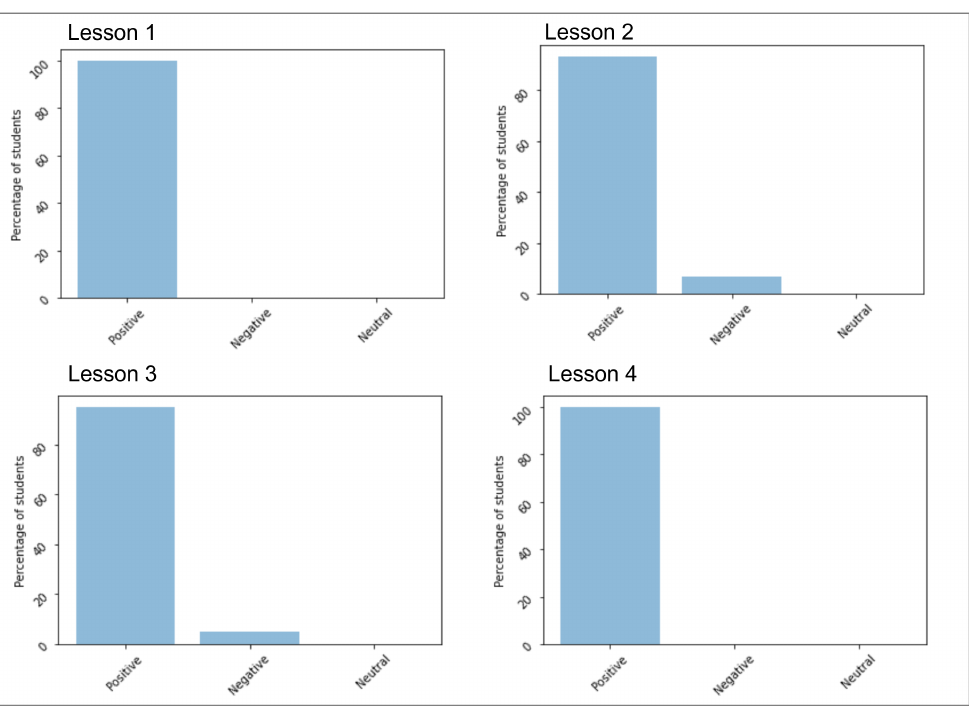
Figure 7. Sentiment analysis for each